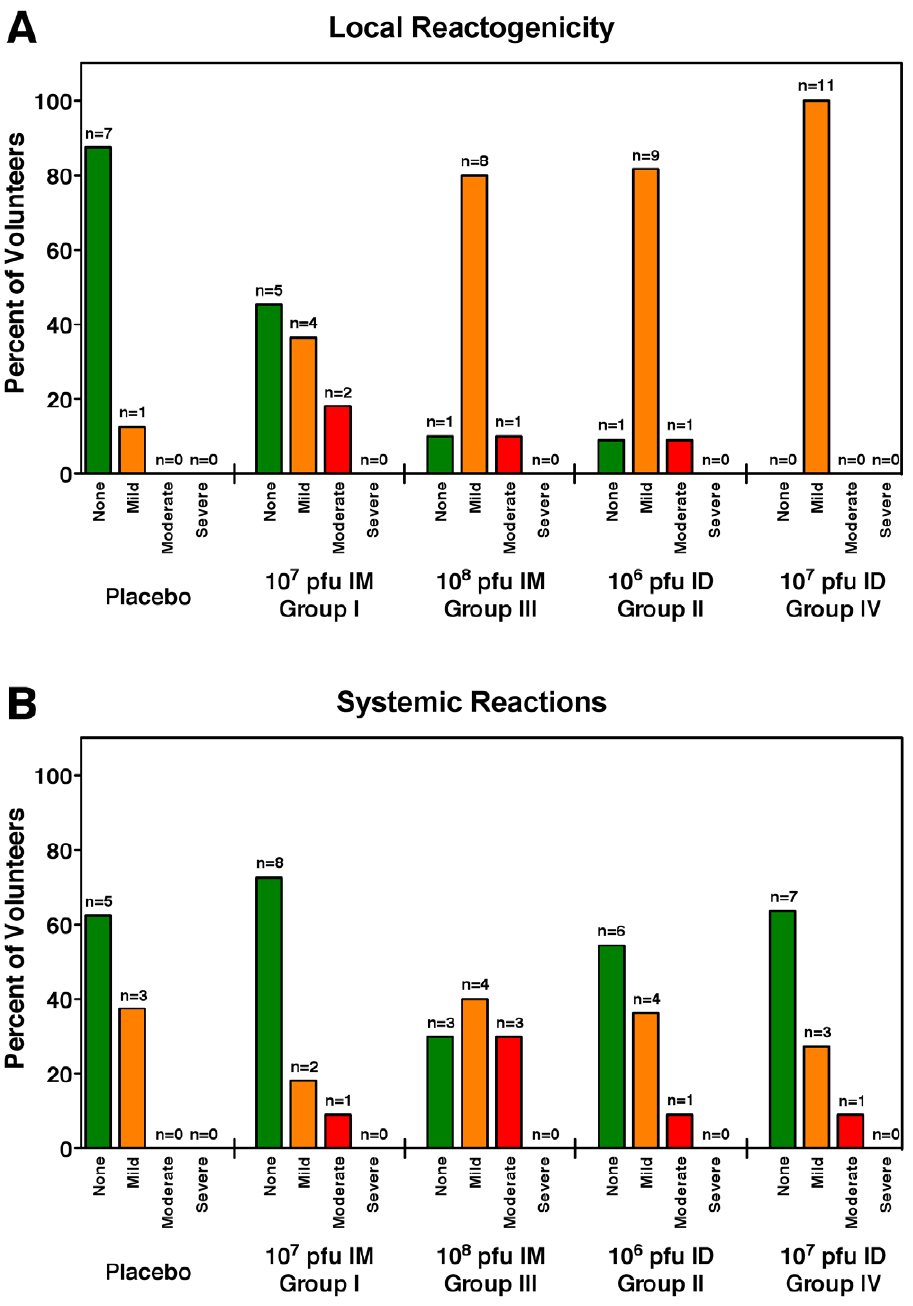
Figure 2. Systemic and local vaccine related reactogenicity for each dose and route of vaccination. The number and percent of subjects experiencing one or more local (panel A) or systemic (panel B) reactions is shown for each group after stratification by severity. The most severe reaction experienced by a volunteer determined the stratification into none, moderate, mild or severe categories. No serious or life threatening adverse events were